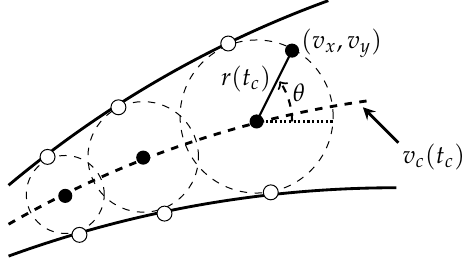
Figure 9. VO built with intent information. The VO circles are centered at v c ( tc )